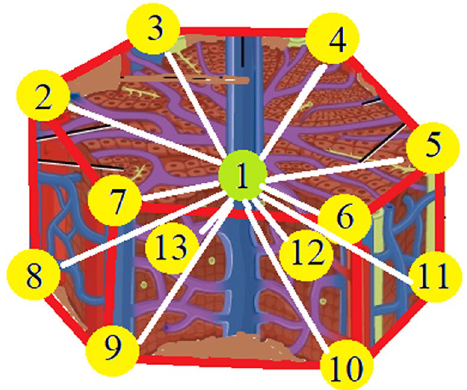
Figure 8. Representation of the twelve nearest neighbors of the green atom.